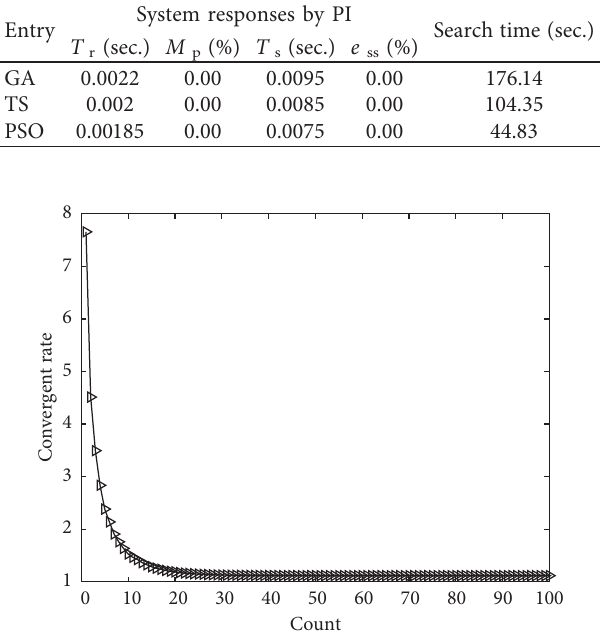
Figure 14: Shows the result of convergence towards the answer while searching the PI value using PSO